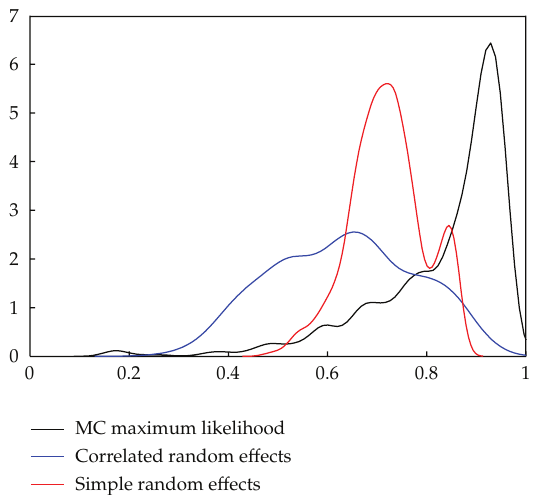
Figure 2: Kernel density estimates of e ffi ciency scores from the three